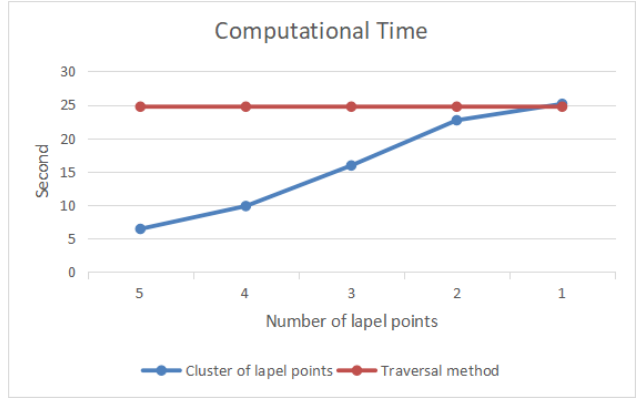
Figure 41. The effect of the number of lapel points on the retrieval efficiency. If the lapel points in the skyline are removed, then the retrieval efficiency is greatly